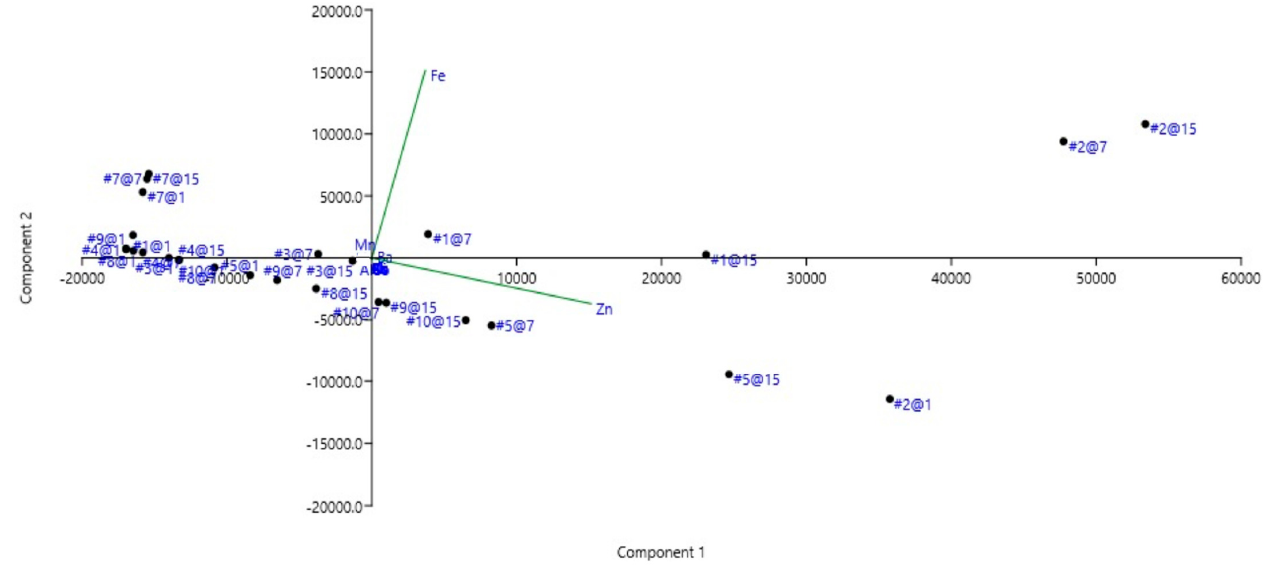
Figure 5. Principal component analysis of the overall data. Each point represents the item (#) and